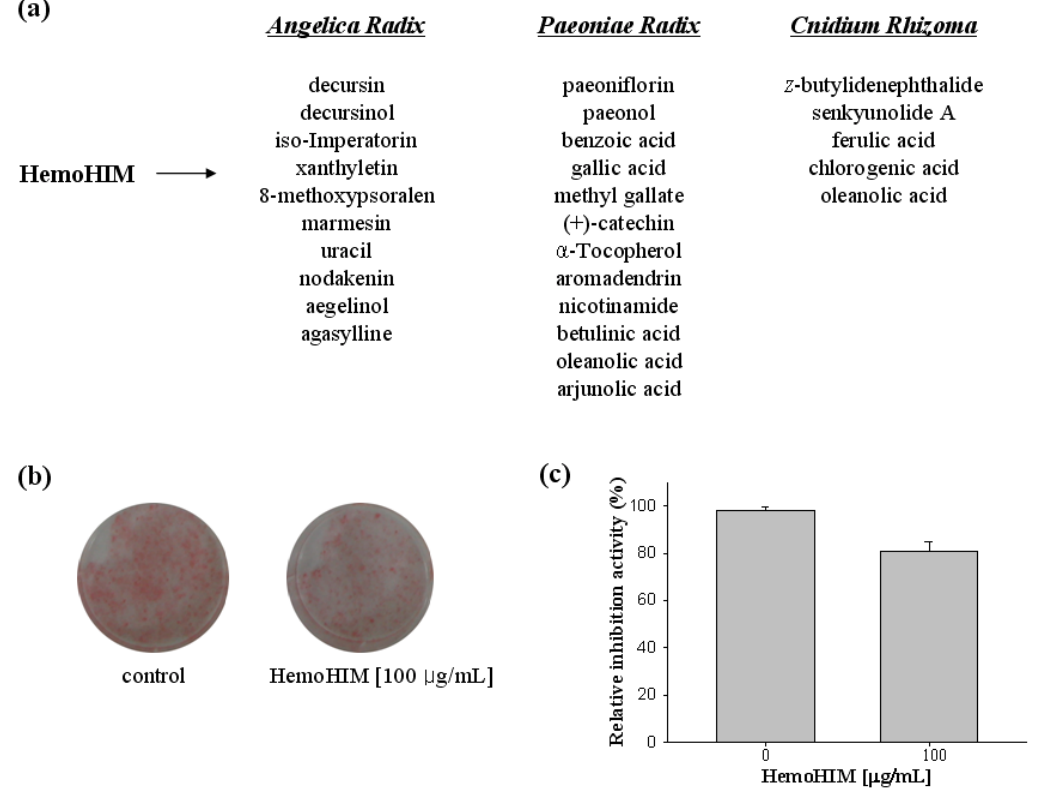
Figure 1. ( a ) Composition of HemoHIM. ( b ) Relative inhibition activity by HemoHIM treatment ( c ) Quantification analysis by Oil Red O staining.